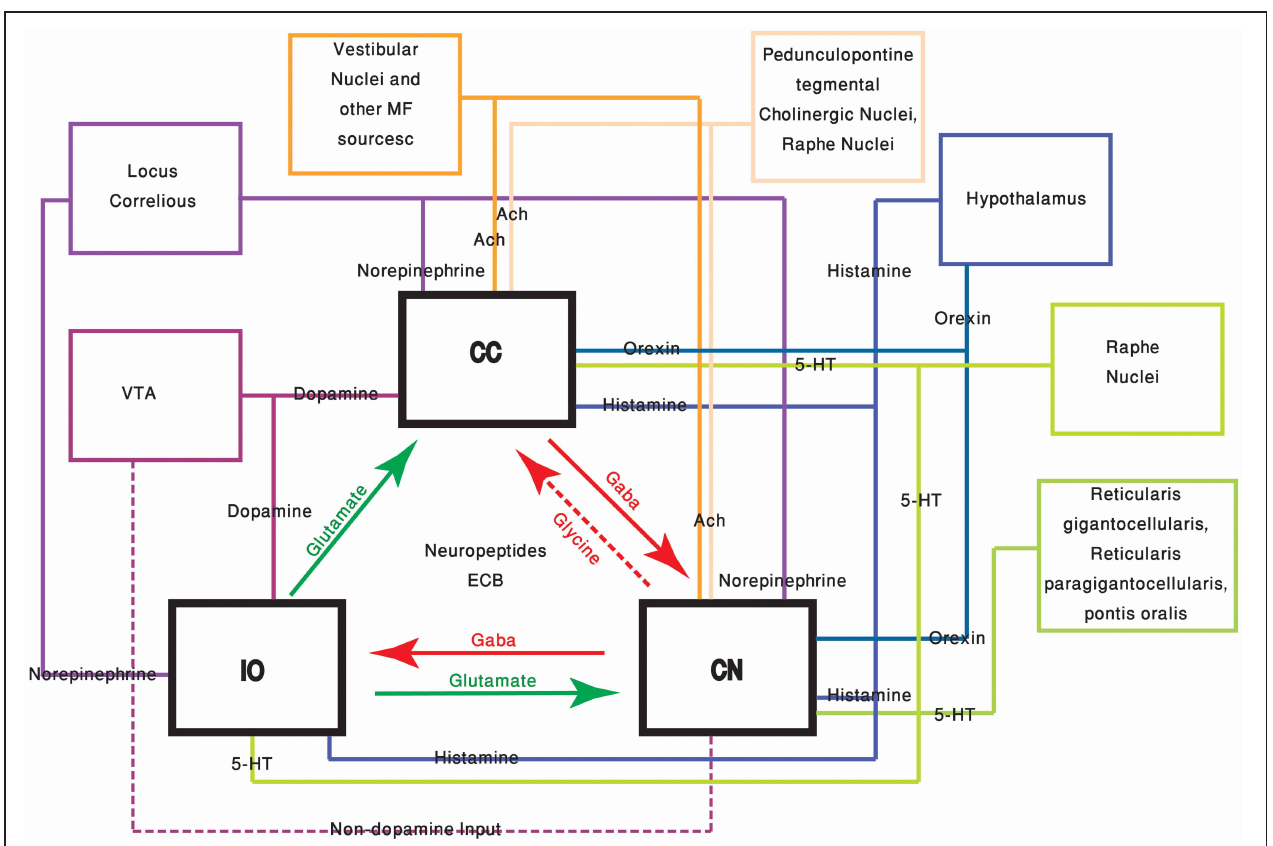
histamine—marked, respectively, in light and dark blue. Both are secreted from cells located in different areas in the hypothalamus. Ach—marked in light and dark orange. The two main sources are precerebellar regions and nuclei in the reticular formation. Note that cholinergic input to the IO is not represented in the diagram. Norepinephrine—marked in dark purple. Dopamine—marked in light purple. Dashed line represents input from the VTA to the CN which is not dopaminergic. Autocrine signaling of dopamine in PCs (Kim et al., 2009) is not represented in the